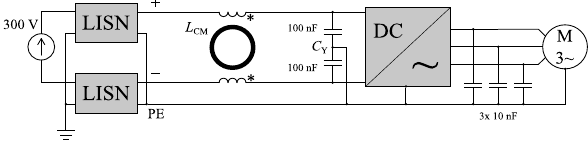
Fig. 3. S chematic d iagram of the proposed measuring stand for passive filters.